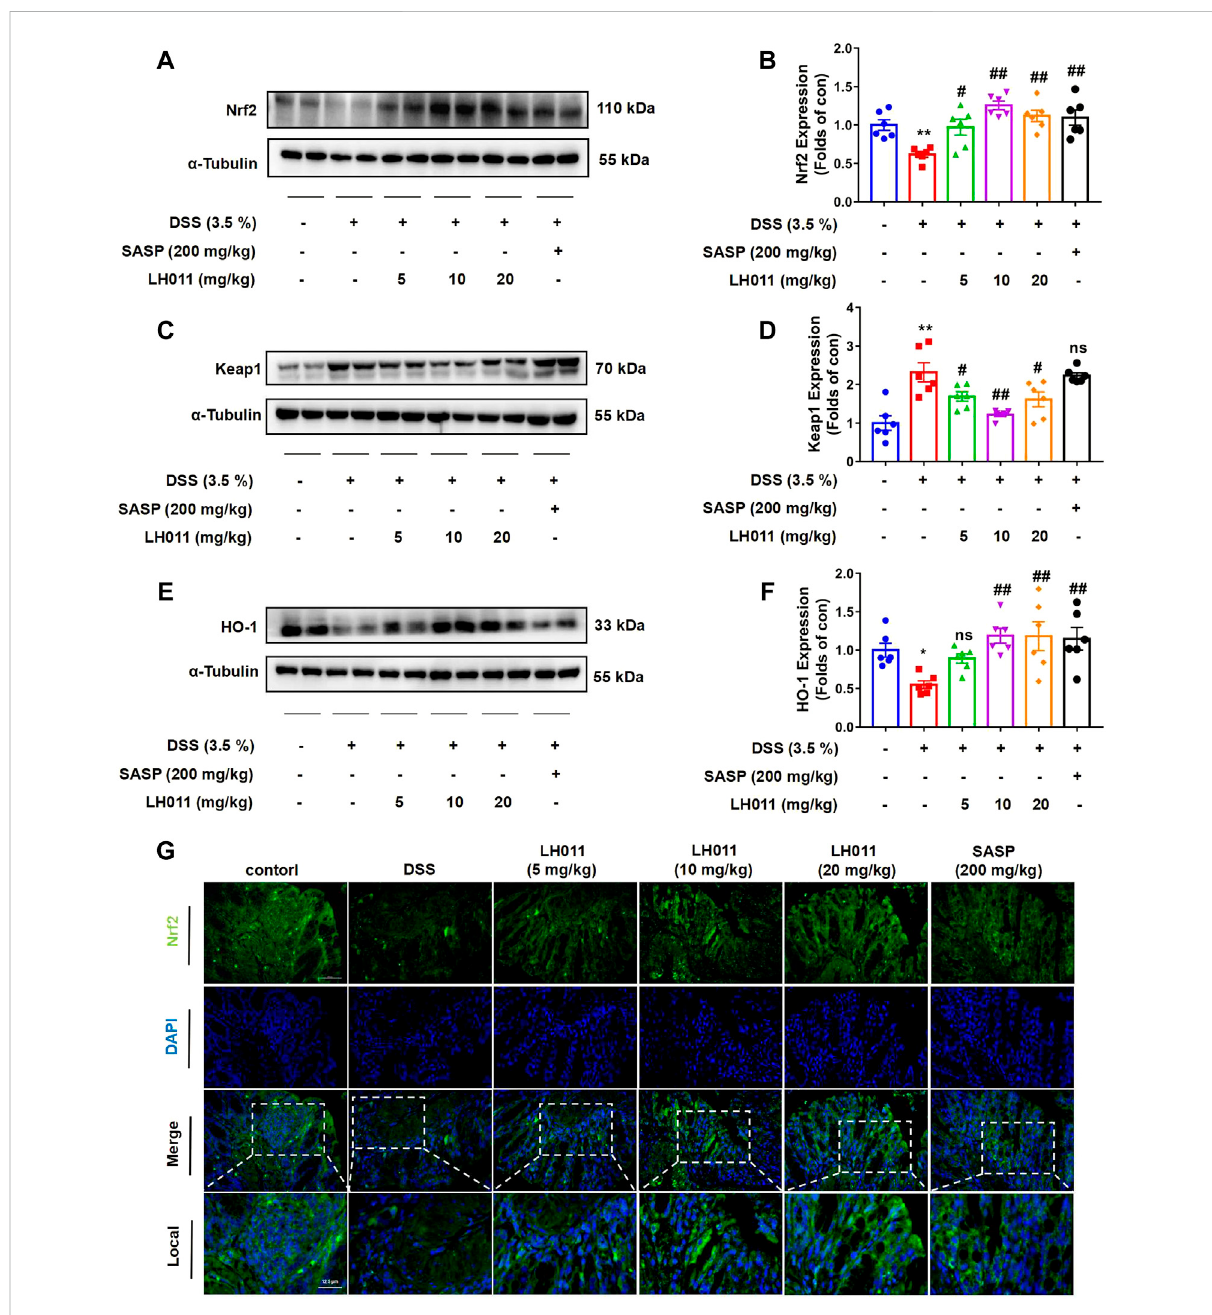
FIGURE 6 LH011 enhanced antioxidant defenses by activating Nrf2/Keap1/HO-1 signaling pathway in DSS-induced mice colitis. (A – F) Protein levels of Nrf2, Keap1, and HO-1 in colonic tissue were measured by Western blot. n = 6. (G) Immuno fl uorescence results of Nrf2, scale bar: 50 μ m, n = 3. All data are presented as the mean ± SEM. * p < 0.05, ** p < 0.01 vs. control group; # p < 0.05, ## p < 0.01 vs. DSS group; ns, no signi fi